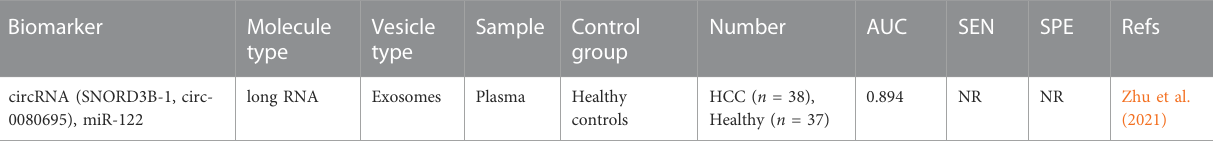
TABLE 1 ( Continued ) Potential biomarkers identi fi ed in genomics or transcriptomics